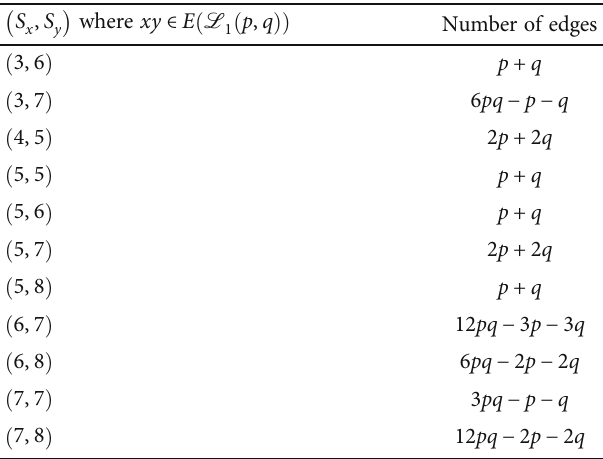
Table 2: The edge partition of L of